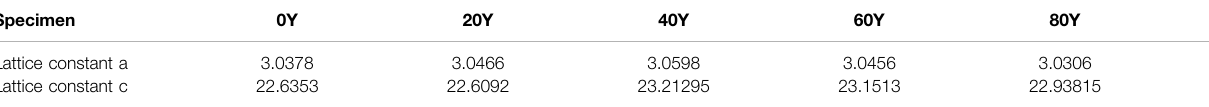
Lattice constant c